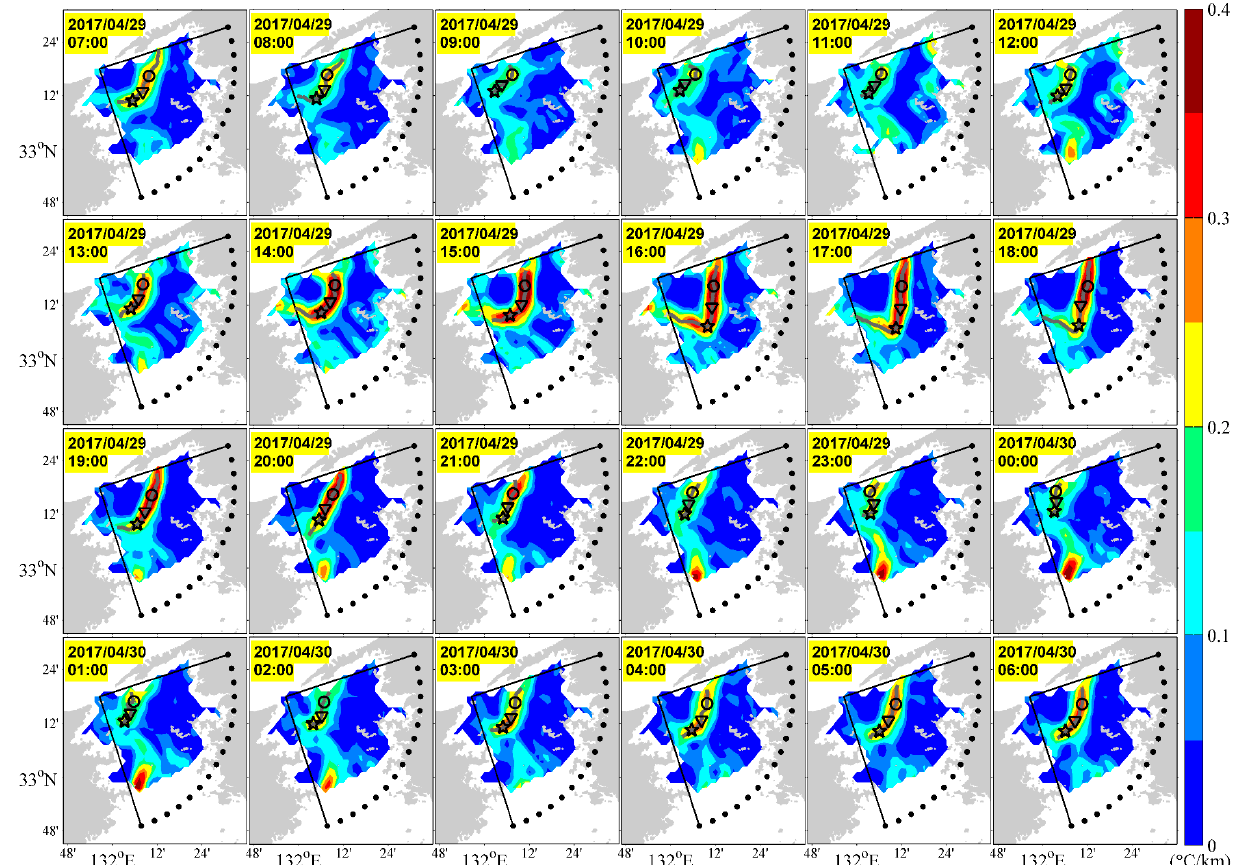
Figure 3. SST gradient magnitudes of the continuous hourly SST data from 07:00 29 April to 06:00 30 April 2017 (UTC+9) during spring tide. The thick black lines indicate the position of the tidal front, and the star, triangle, and circle denote three representative points.